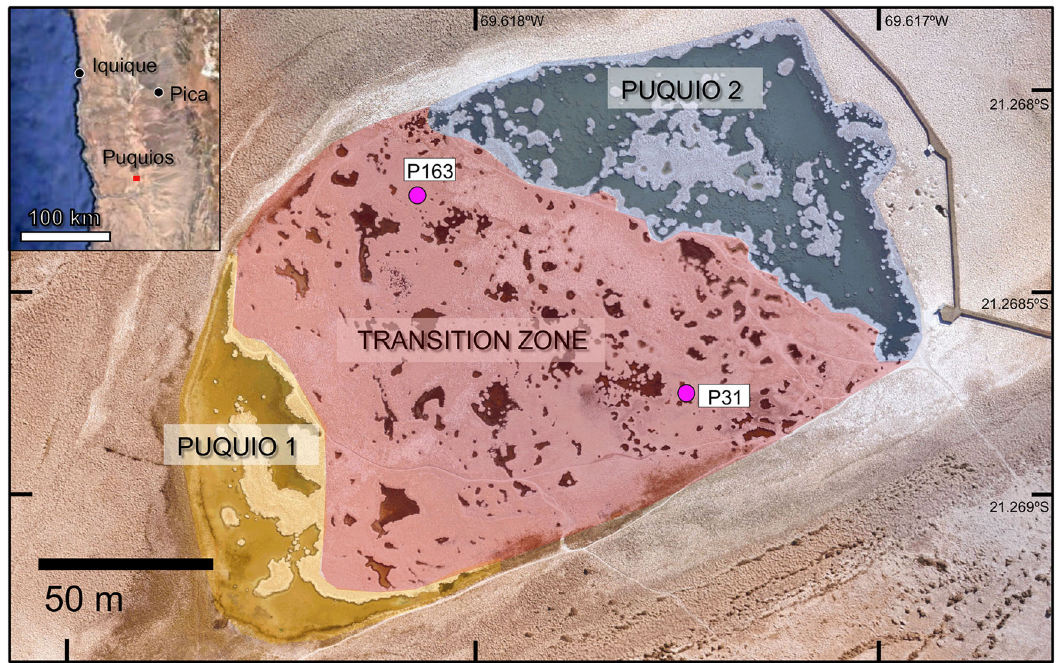
Fig. 1 Study site. Location map of the Puquio 1 – Puquio 2 system of the Salar de Llamara showing Puquio 1 highlighted in yellow, the Transition Zone highlighted in red, and Puquio 2 highlighted in blue. Collected samples are shown with pink markers and labelled by pond number. Inset with geographic context: Google, Landsat/Copernicus, SIO, NOAA, U.S. Navy, GEBCO, LDEO-Columbia, NSF, NOAA. Base map: drone imagery collected in November 2017.